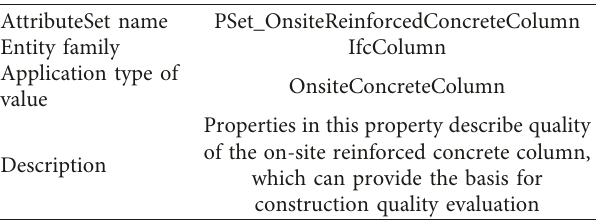
Table 7: The definition of IfcPropertySet of cast-in-place rein- forced concrete column.